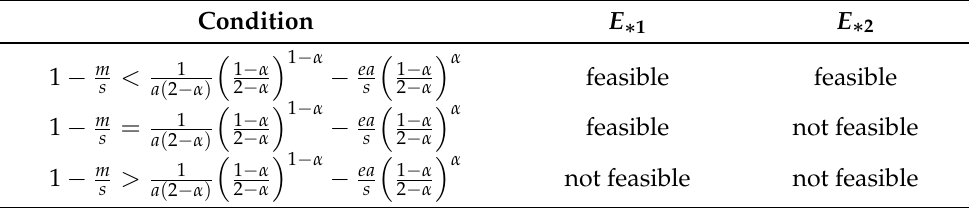
Table 3. Conditions for feasibility of the interior equilibria of the system in (23) and (24) when m < s .